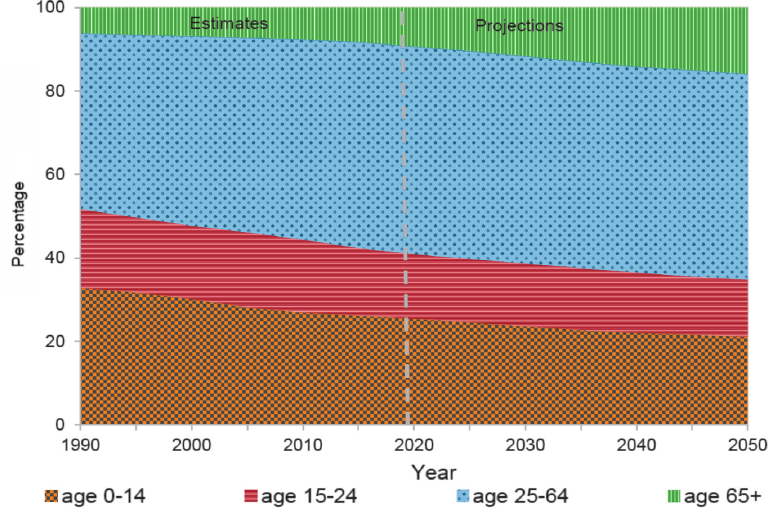
Figure 1. Percentage of the total population by sex and age group and the estimation of aging population growth [3] . growth